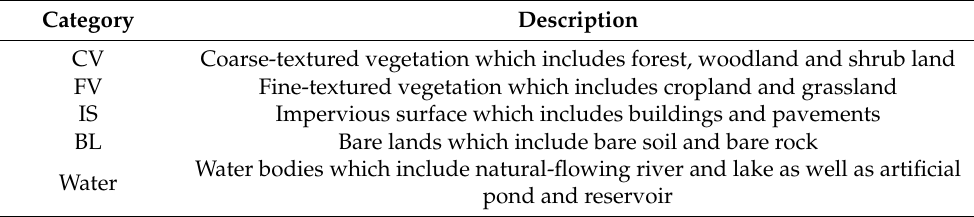
Table 2. Land cover categories and their detailed information.